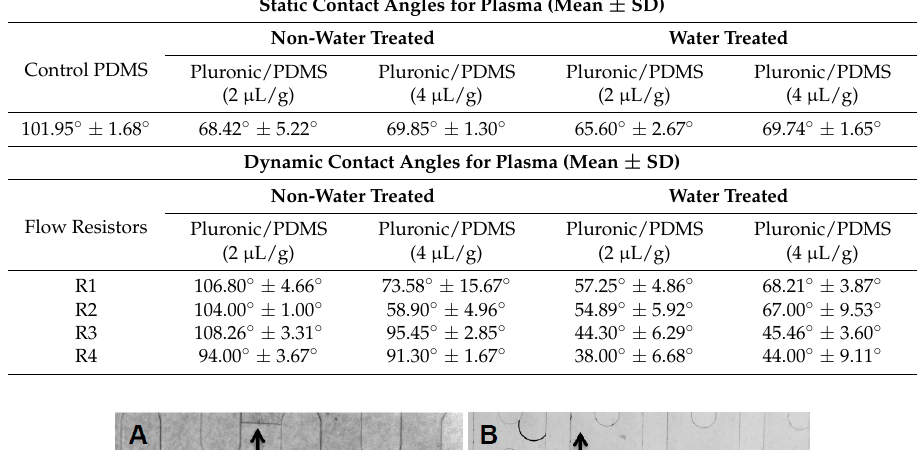
Table 3. Measured static and dynamic contact angles of plasma.